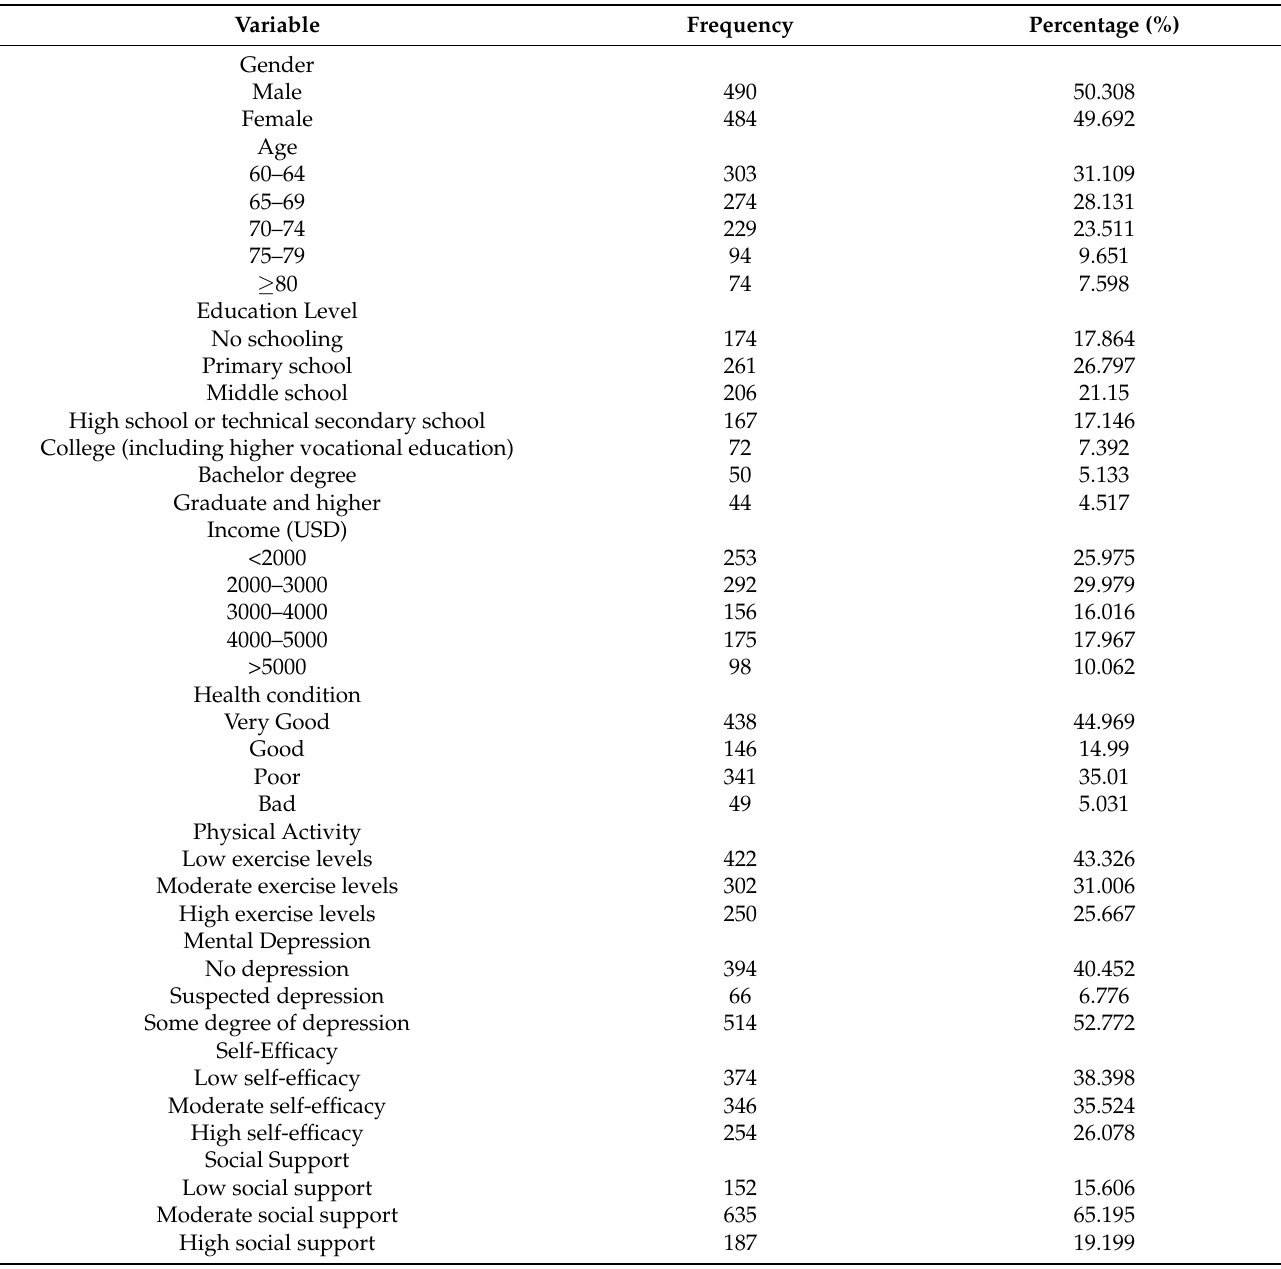
Table 1. Demographic characteristics of the